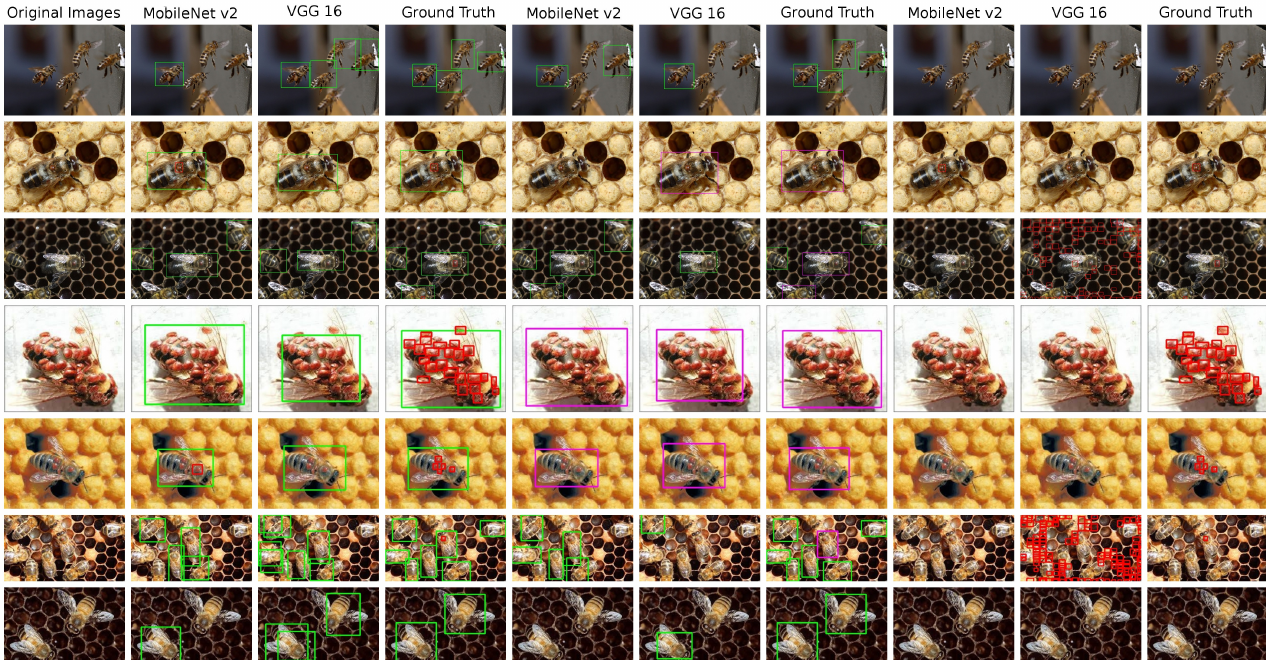
Figure 6. An overview of the detections performed on test images by the SSD models, complemented by ground truth annotated images. 1st column: original image; 2nd–4th column—model trained in bees and V.-mites detection; 5th–7th column: models trained in healthy and ill bees detection; 8th–10th column: models trained in V.-mite detection